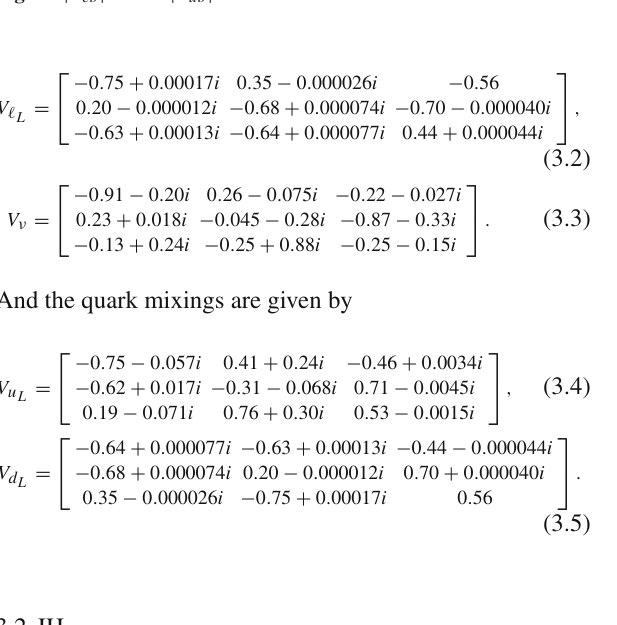
Fig. 8 | V cb | versus | V ub